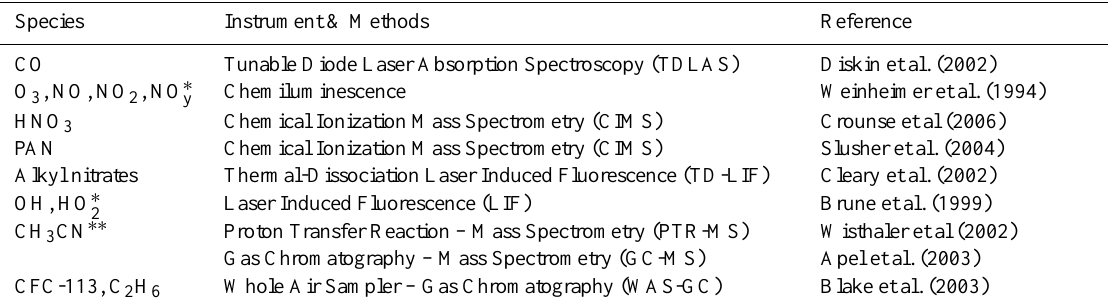
Table 1. Summary of ARCTAS observations used in this study.